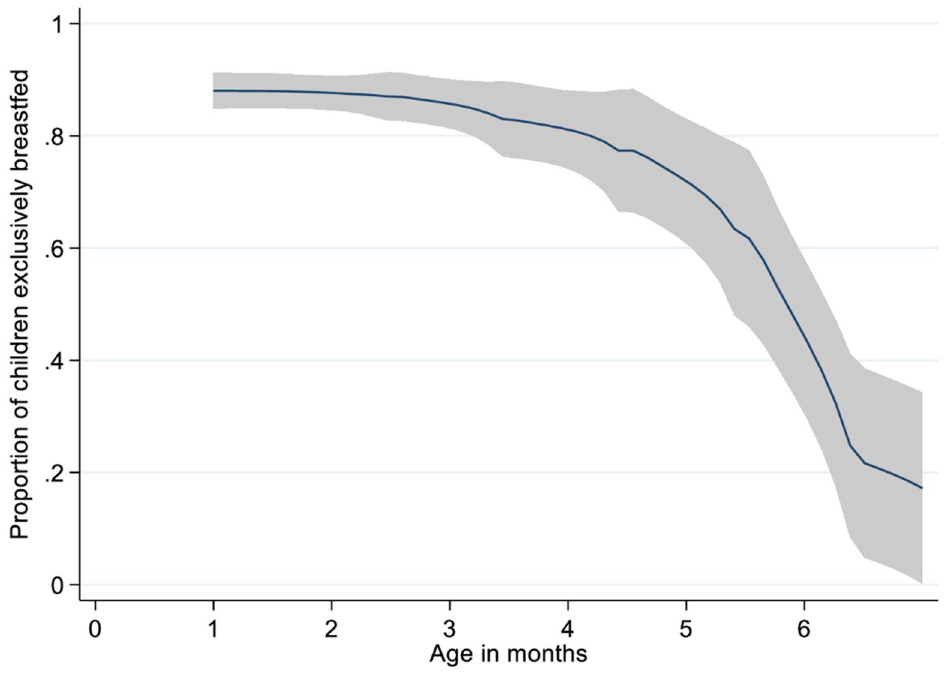
Fig 1. Proportion of exclusive breastfeeding by age in months.